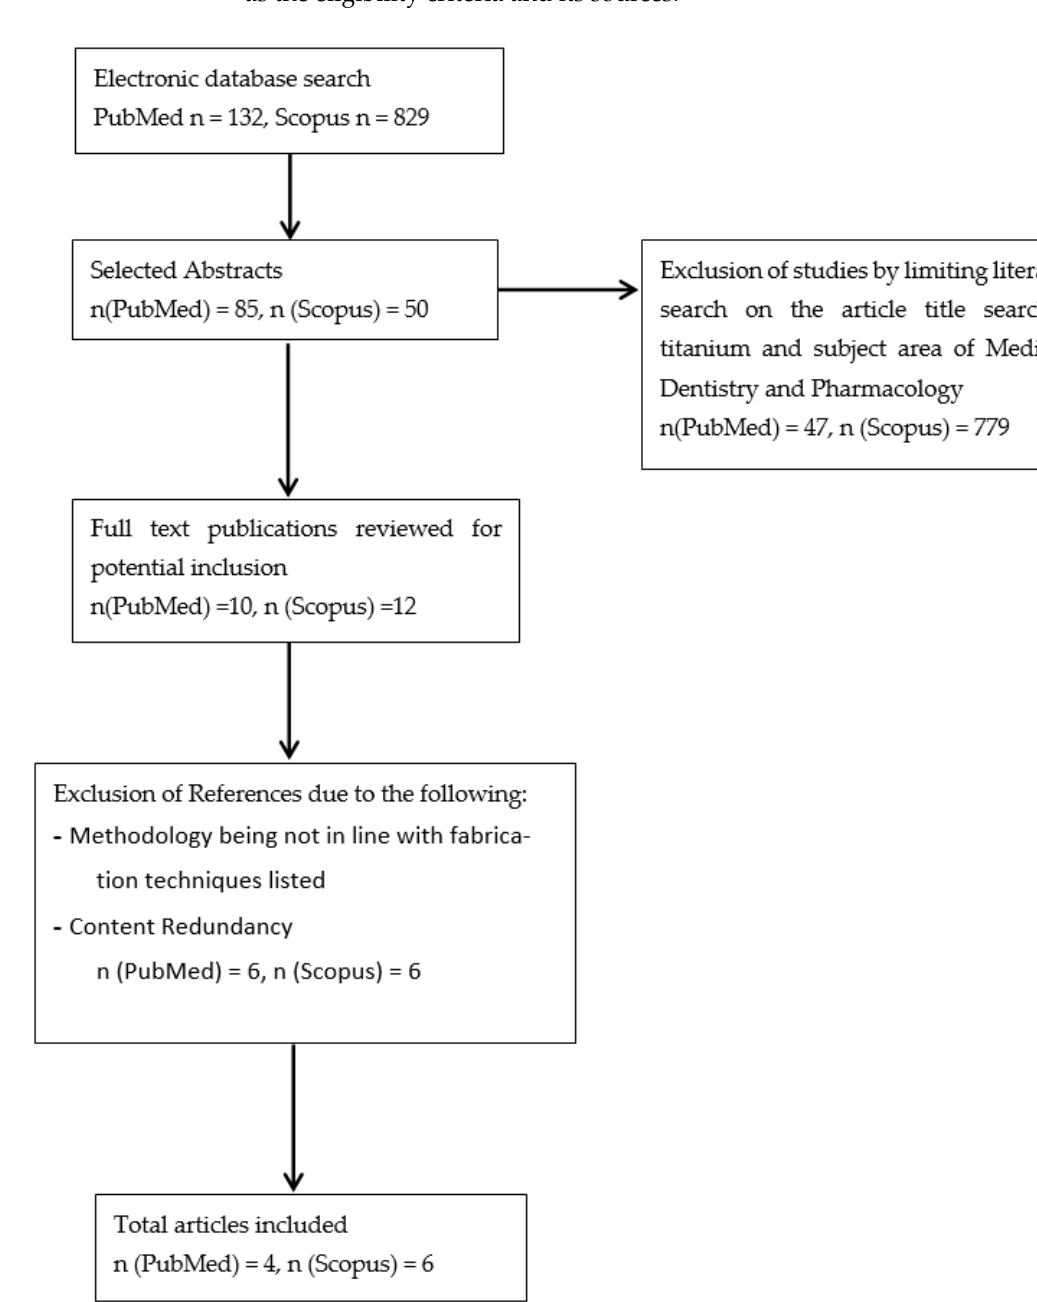
Figure 1. Flowchart of the Selection Criteria Process.